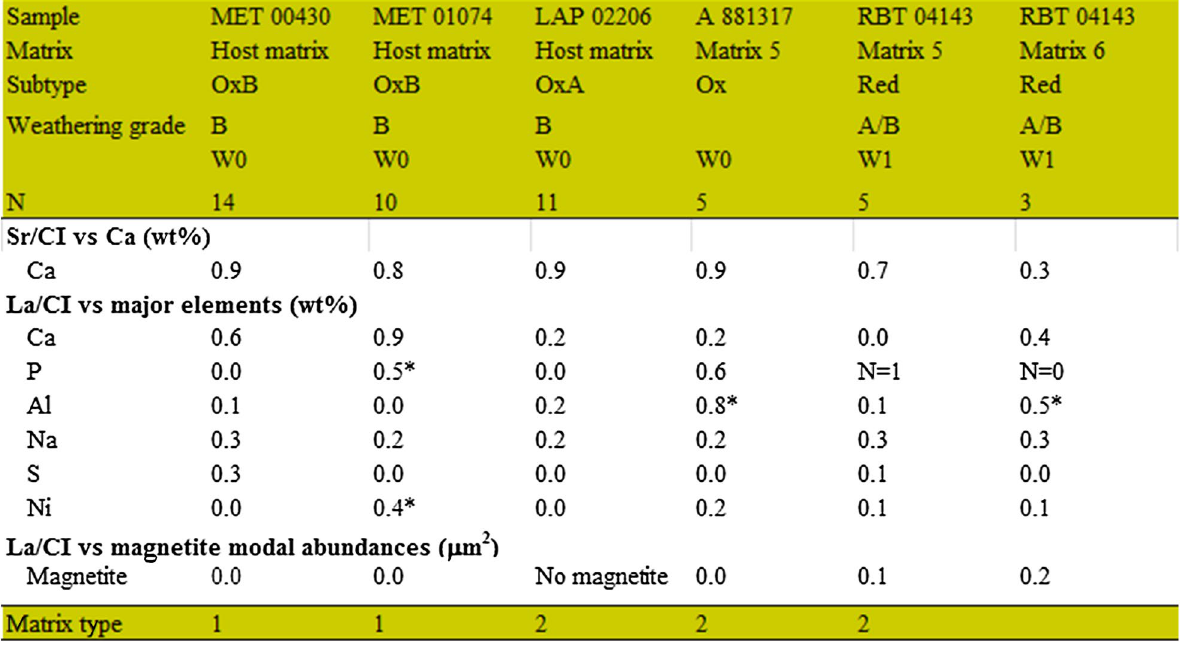
N : number of data a Negative